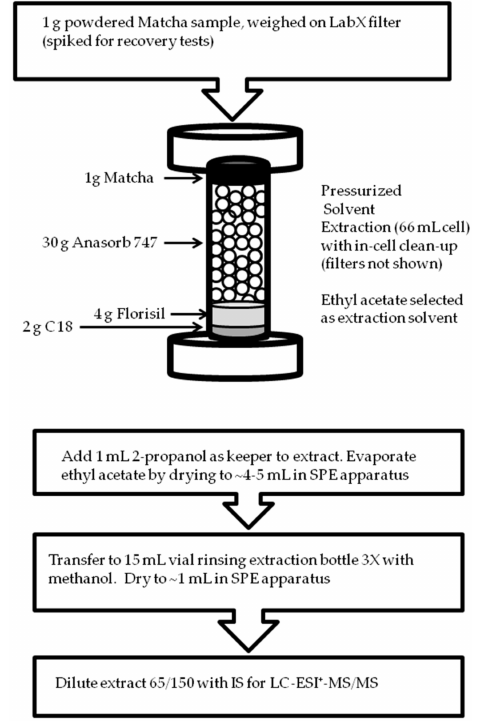
Figure 1. Sample preparation method for conazole fungicide